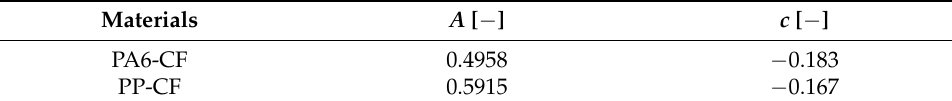
Table 7. Model constants for the proposed semi-empirical fatigue life prediction models.